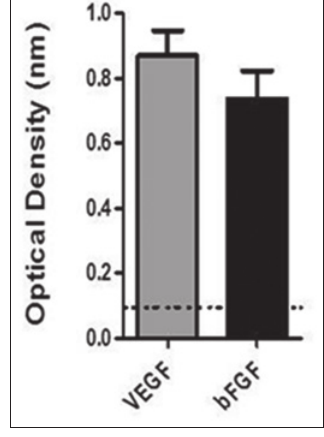
Figure-1: Identification of several cytokine on the human umbilical mesenchymal stem cells conditioned medium (HU-MSCM). To identified growth factor and cytokine which involved in wound healing enzyme-linked immunosorbent assay was performed, after measurement in 450 nm, could be defined HU-MSCM contain some growth factor such vascular endothelial growth factor (gray bar) and basic fibroblast growth factor (black bar).